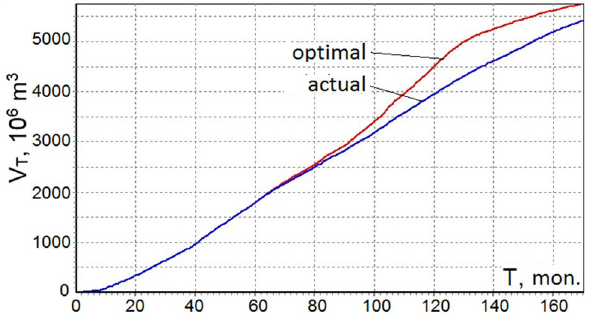
Fig. 4 Total gas production from the Kotelevske gas reservoir with optimal and «actual» modes of development